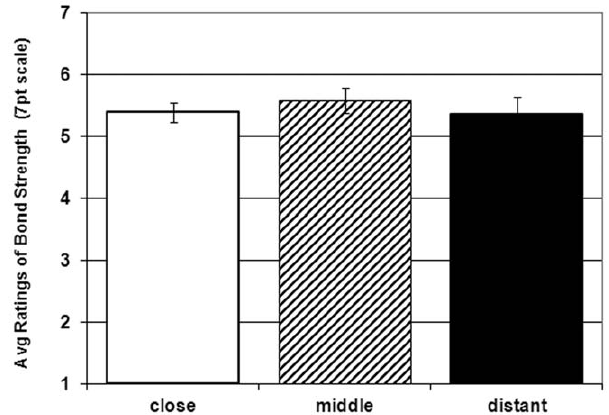
Figure 1. Participants’ mean ratings of their closeness to their family and hometown as a function of what condition the subject was assigned to (error bars show standard error of the